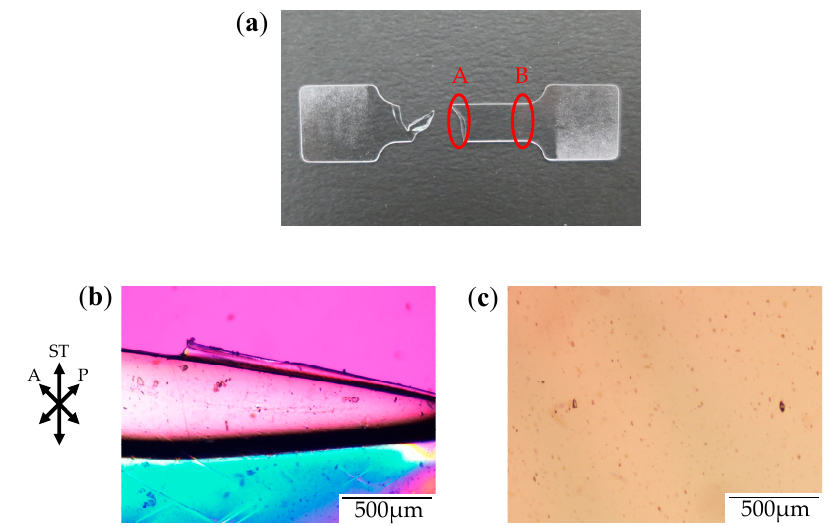
Figure 13. Photograph and polarized optical micrographs of OD-PC obtained by stretching CO 2 -absorbed PC under air at atmospheric pressure at 30 °C after absorbing and releasing CO 2 at 5 MPa: ( a ) Photograph of fractured specimen; ( b ) Polarized optical micrograph for region A; and ( c ) Polarized optical micrograph for region B.